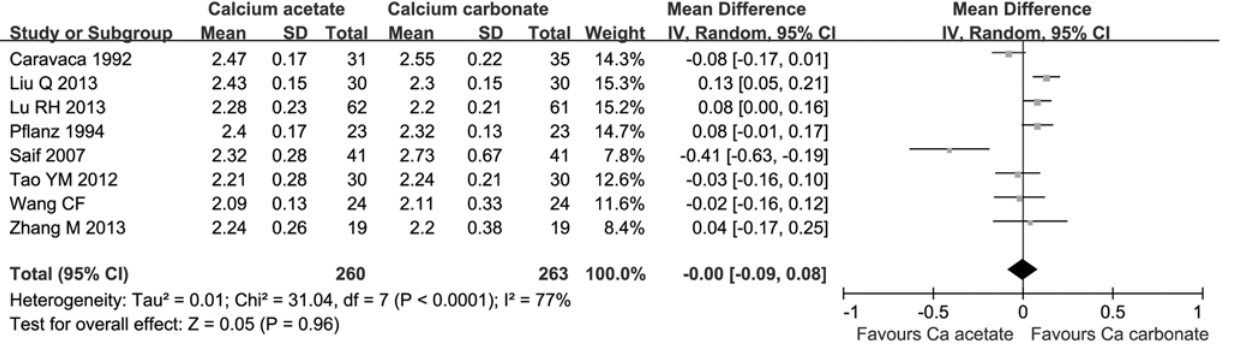
Fig 3. Serum calcium levels after 8 weeks administration of calcium-based phosphate binders.